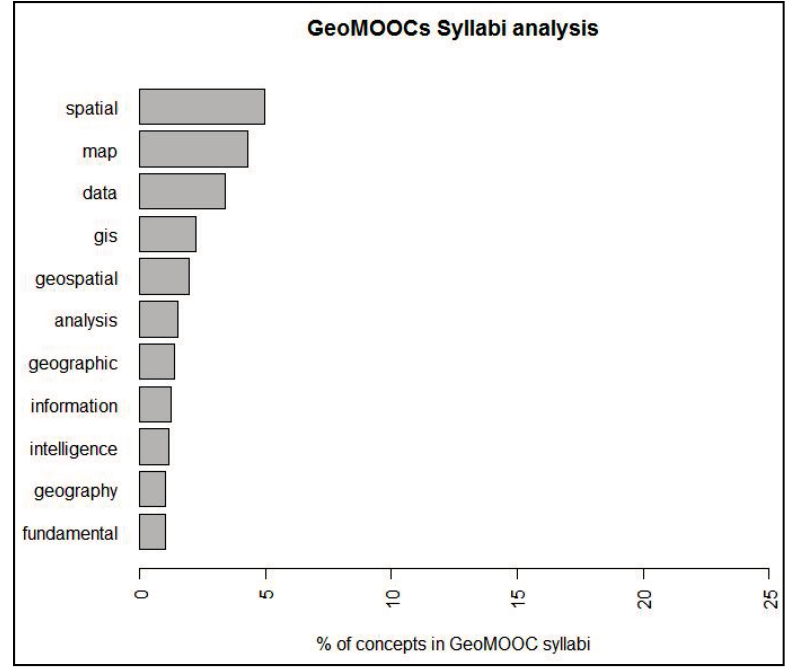
Figure 2. Word frequency counts for key concepts used to describe the available GeoMOOC